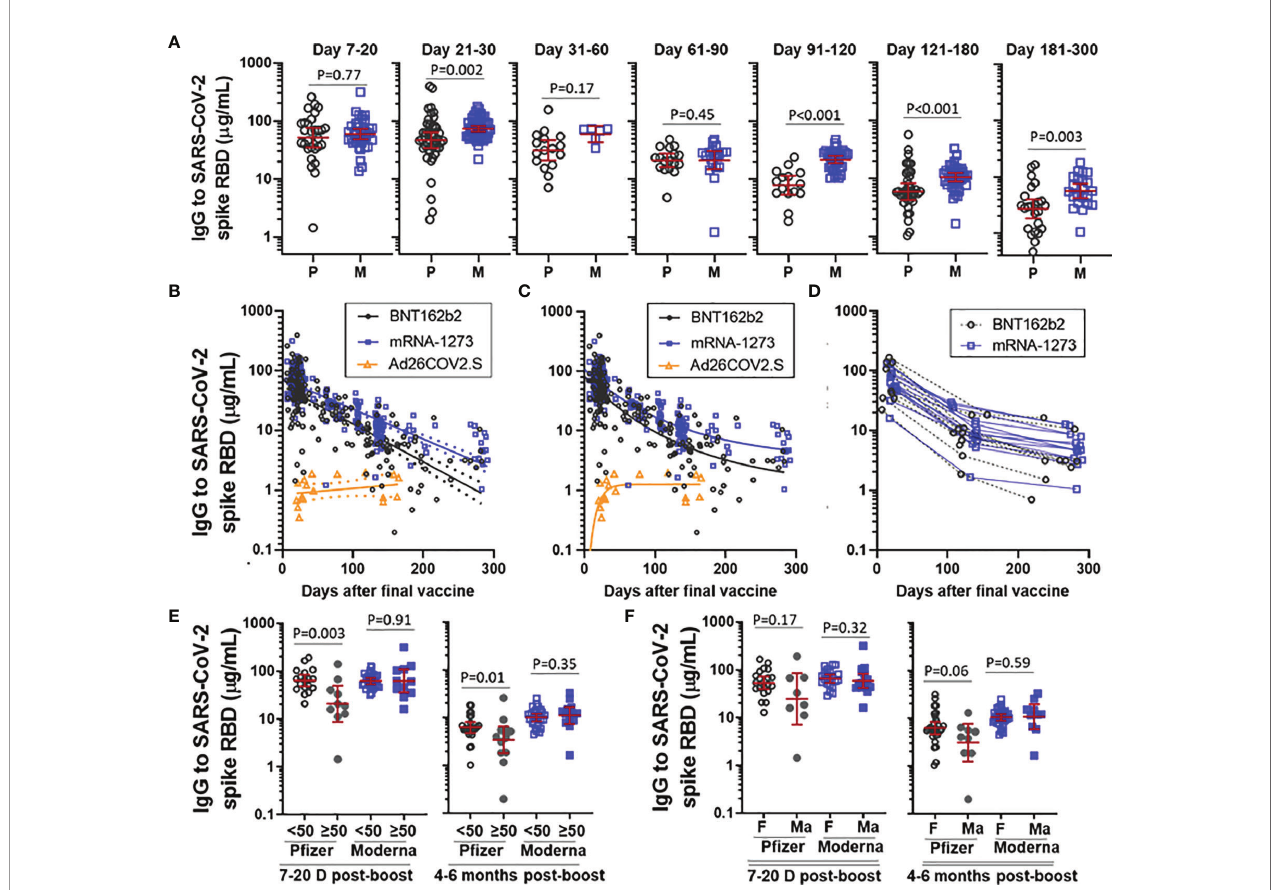
FIGURE 2 | Trajectory of vaccine-elicited IgG over time. (A) Comparison of IgG to SARS-CoV-2 spike RBD in recipients of BNT162b2 (P) and mRNA-1273 (M), strati fi ed by the number of days post-boost. Presented as GM with 95% CI and comparisons with Mann-Whitney U test. (B) IgG trajectory using linear regression modeling, with dashed lines indicating 95%CI. (C) IgG trajectory using one-phase decay model. (D) Paired longitudinal data in subjects who had a sample collected at each of an early (Day 7-20), intermediate (Day 100-150) and late (day 200-300) time point. (E) IgG to SARS-CoV-2 spike RBD strati fi ed by vaccine and age (<50yrs vs ≥ 50yrs) at D7-20 post-boost and 4-6 months post-boost. (F) IgG to SARS-CoV-2 spike RBD strati fi ed by vaccine and sex (female [F] vs male [Ma]) at D7-20 post-boost and 4-6 months post-boost. Subjects with prior COVID-19 infection were excluded from analysis in Figs (B – F)